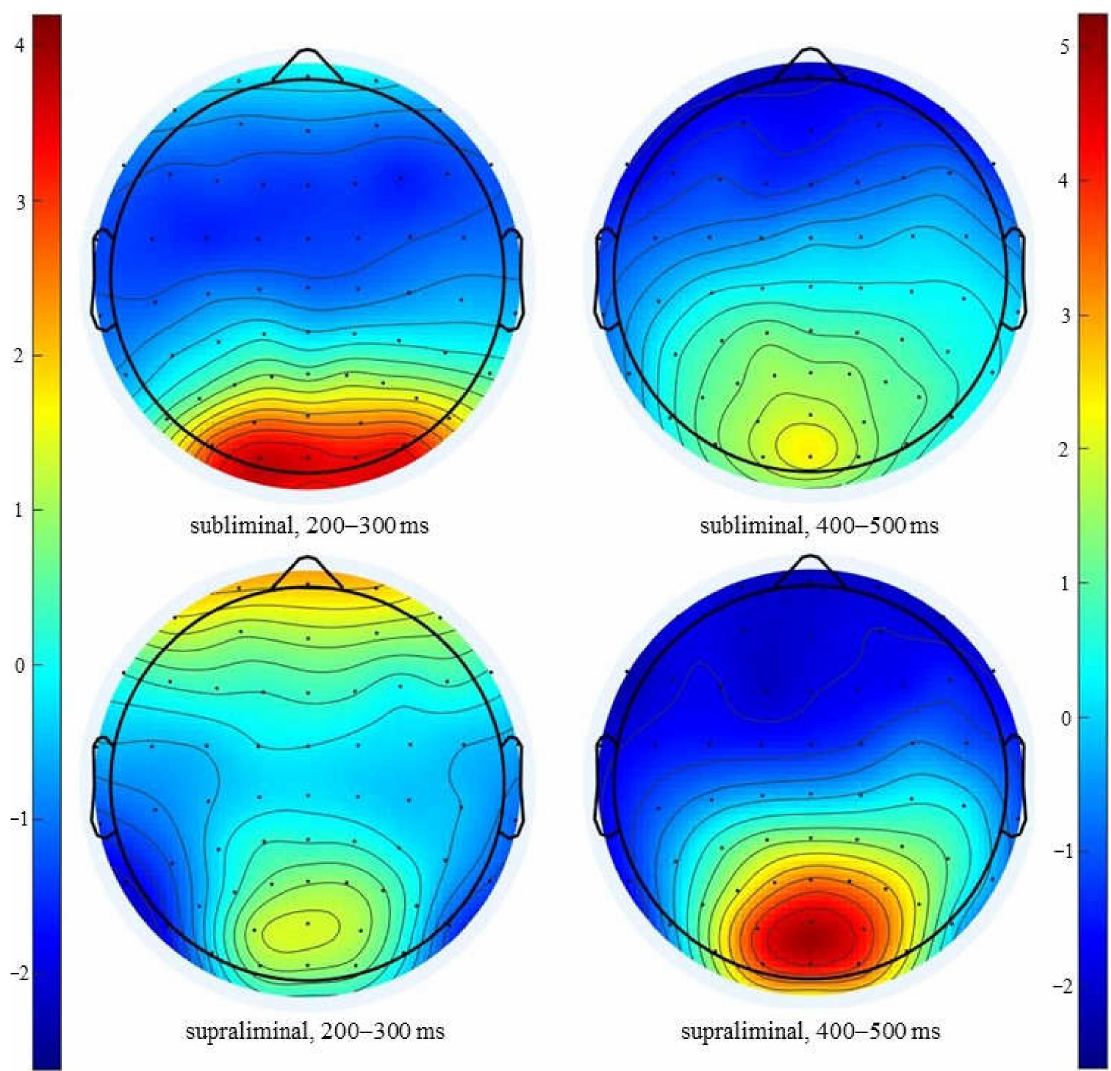
Figure 3. Topographic maps for the mean amplitudes in subliminal and supraliminal conditions, collapsed across face combinations, in the VAN time window (200–300 ms; left panel) and the P3 time window (400–500 ms; right